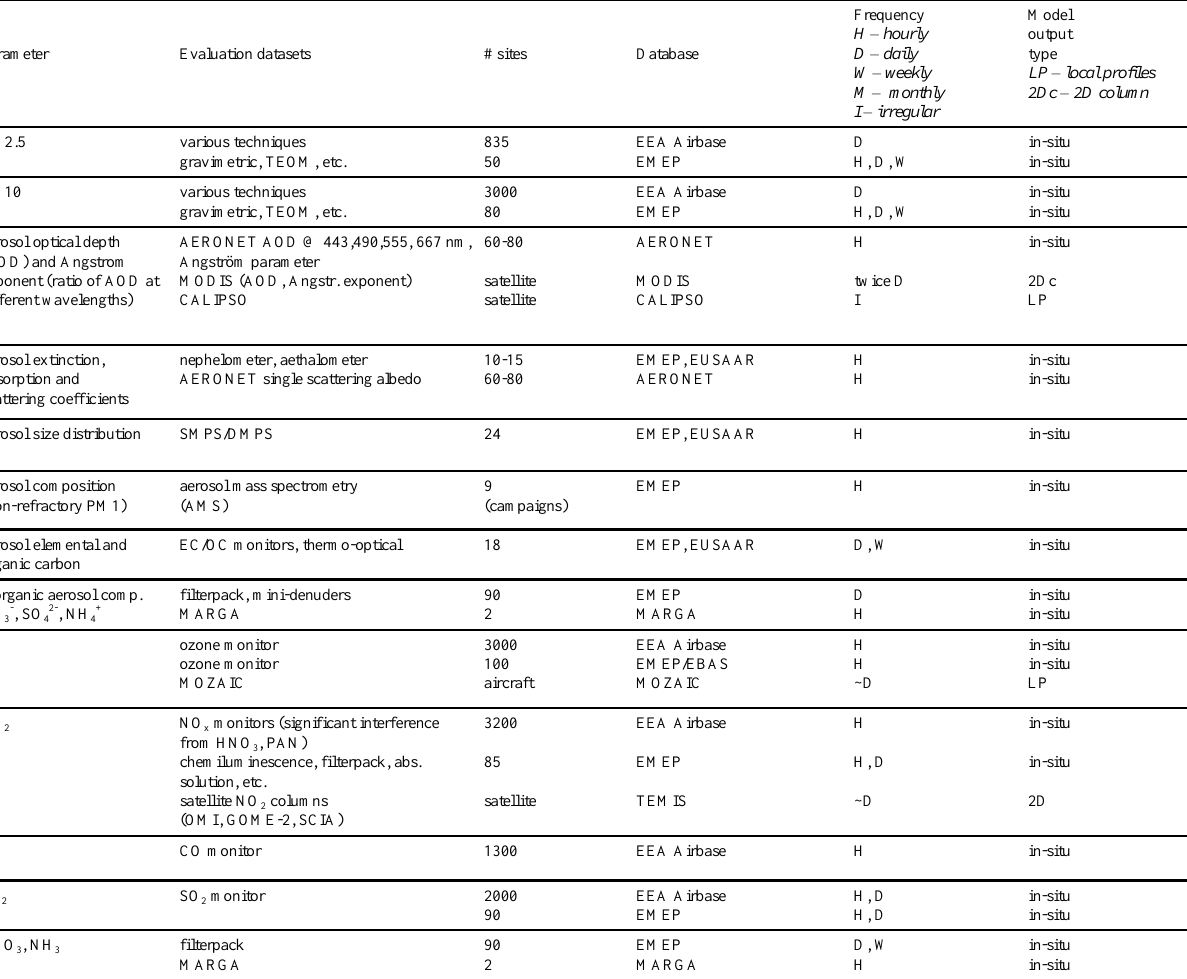
Table B3. Observation data sets available for model evaluation (name, number of sites, frequency of measurements, preferred model output Appendix B3. Observation data sets available for model evaluation (name, number of type).